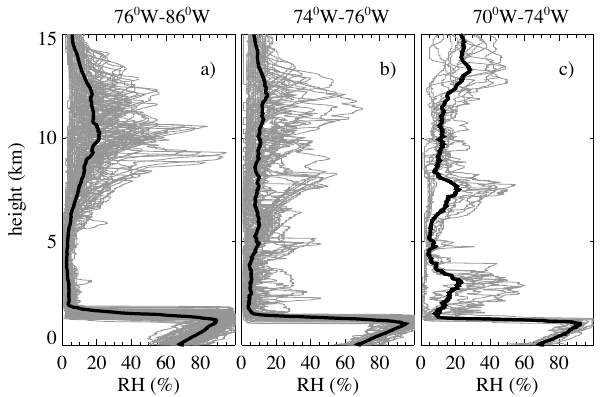
Fig. 6. Ship-launched soundings during VOCALS-REx along 20 ◦ S between (a) 76–86 ◦ W ( N = 77), (b) 74–76 ◦ W ( N = 50), and (c) 70–74 ◦ W ( N = 11). Black lines indicate mean soundings for each longitude bin.